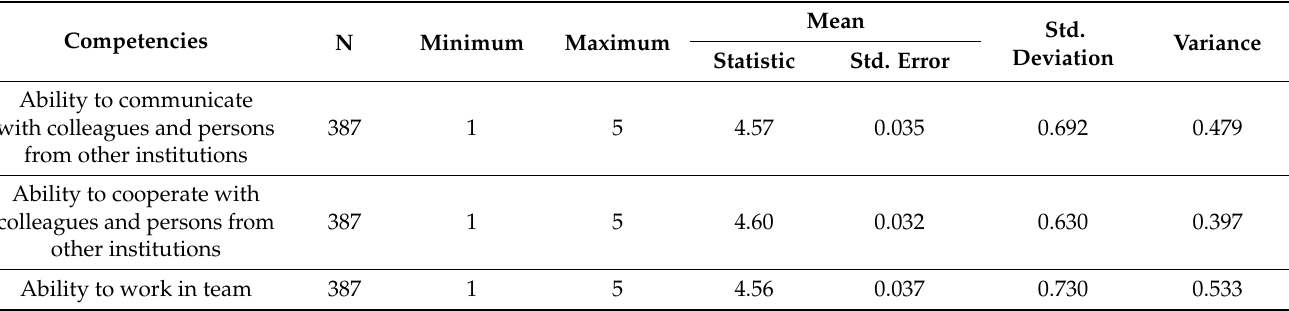
Table 5. Ranking of Social